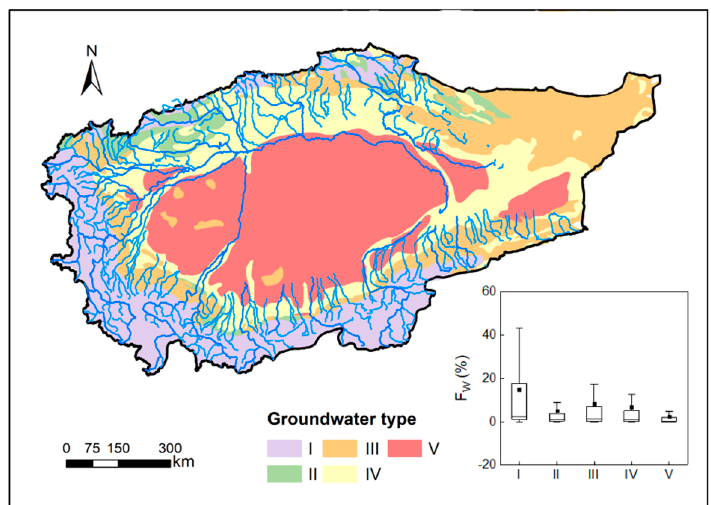
Figure A1. Hydrogeological unit map in the Tarim River basin classified by five major groundwater types, i.e., I, II, III, and IV, corresponding to water above frozen layer, cave water in Karst rocks, fissure water in rocks, pore water in loose soil, and sand dunes in deserts, respectively. The box plots illustrate the variation of streamflow occurrence frequency (Fw, %) in endorheic rivers flowing through different groundwater types.